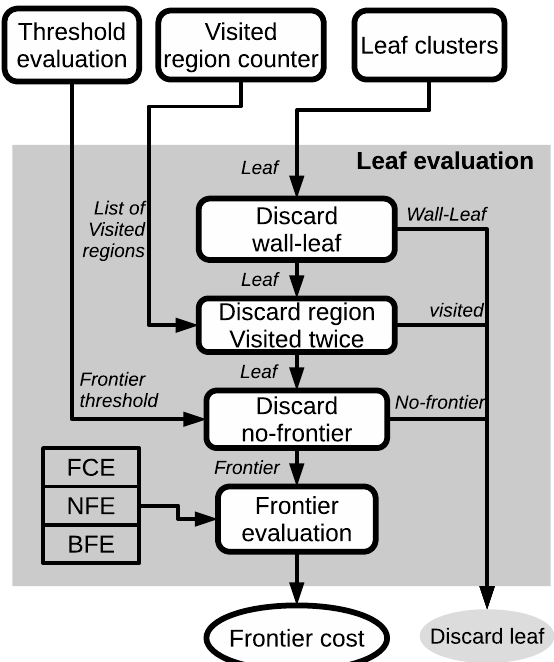
Figure 4. Diagram of the evaluation of potential frontiers.